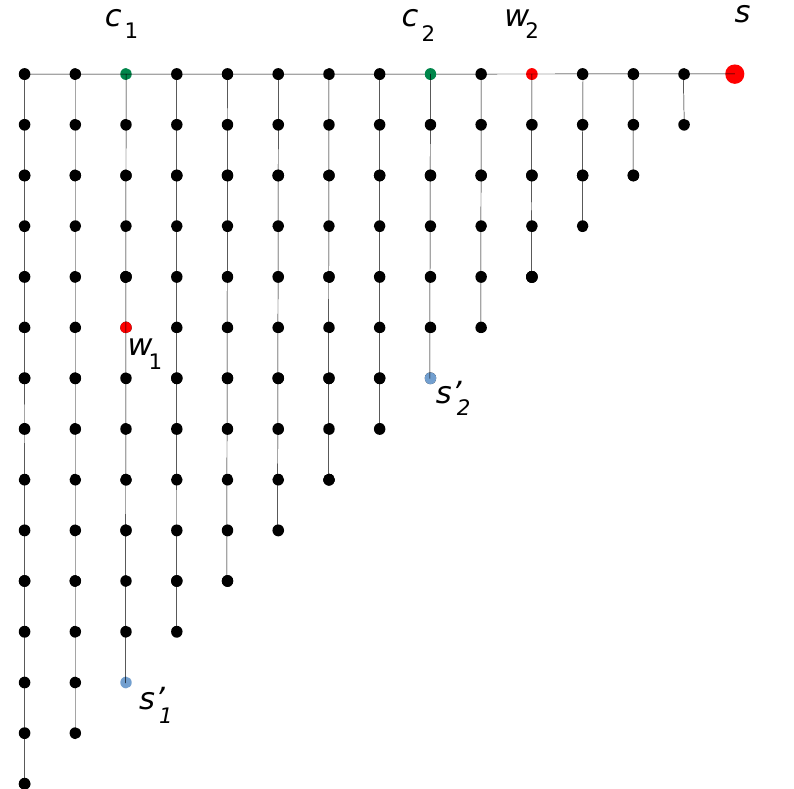
Figure 6. Subtree in the lower left of a shortest path tree and charging